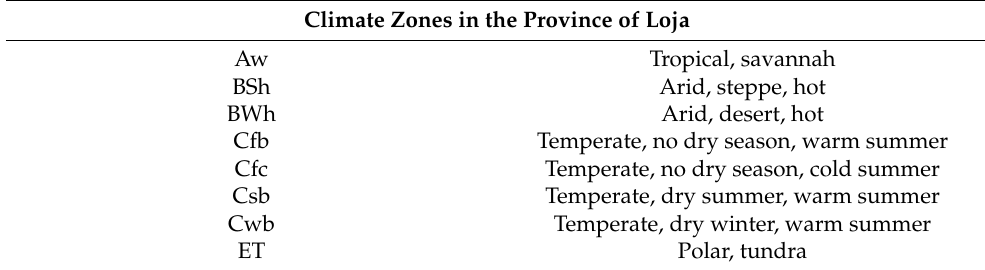
Table 1. Climate zones in Loja (Ecuador), according to Köppen-Geiger-Classification.